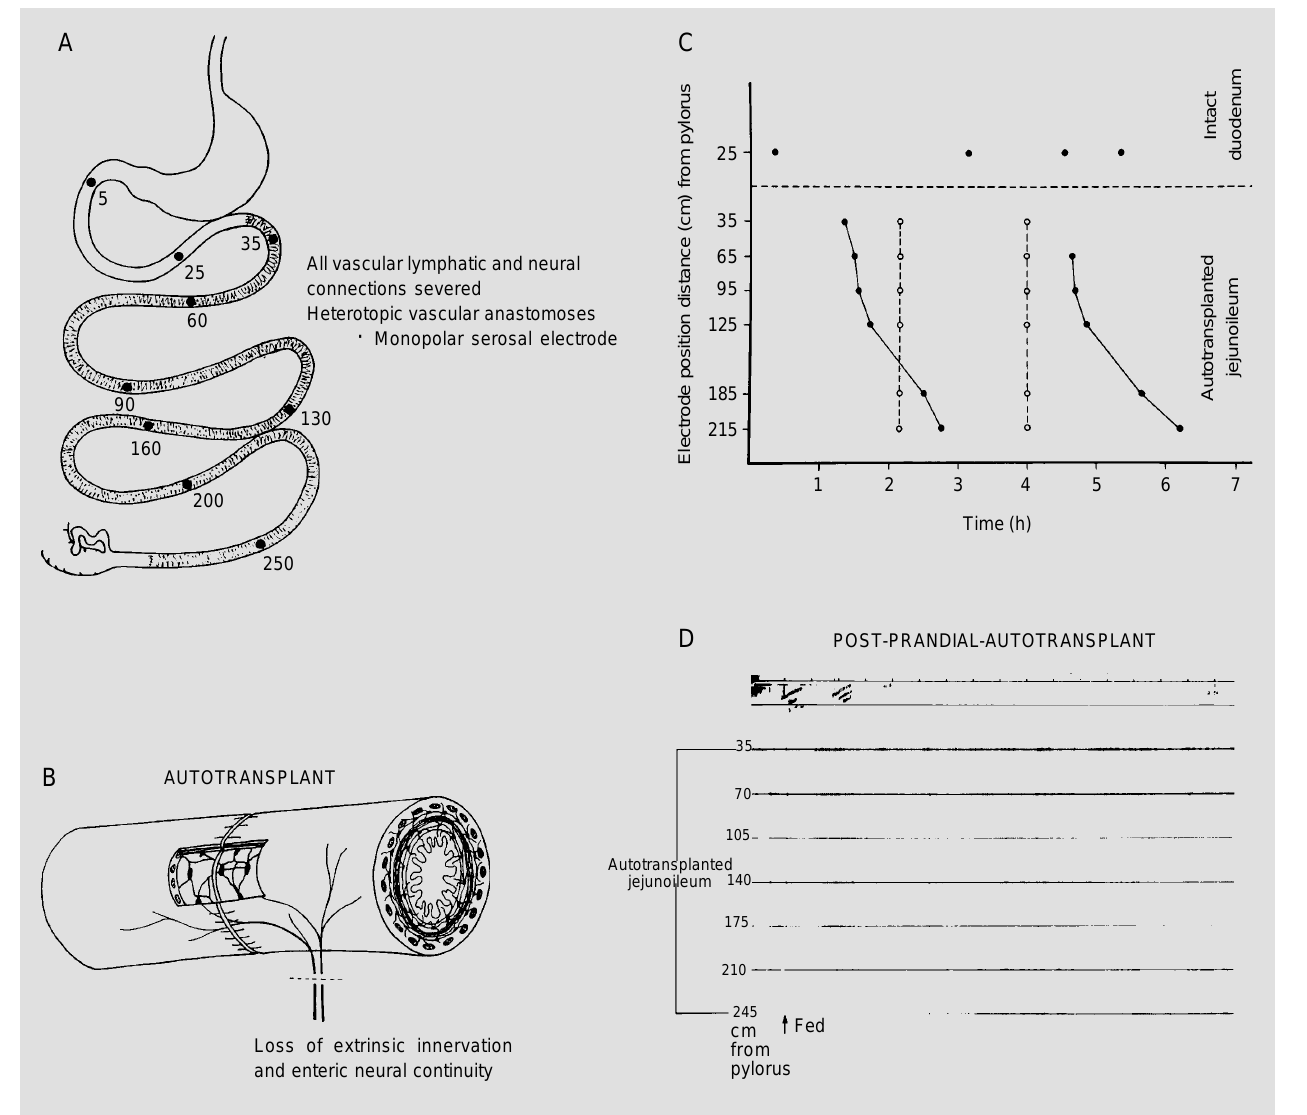
Figure 6 - Effects of autotransplantation (total extrinsic denervation) on intestinal motor activity in a canine